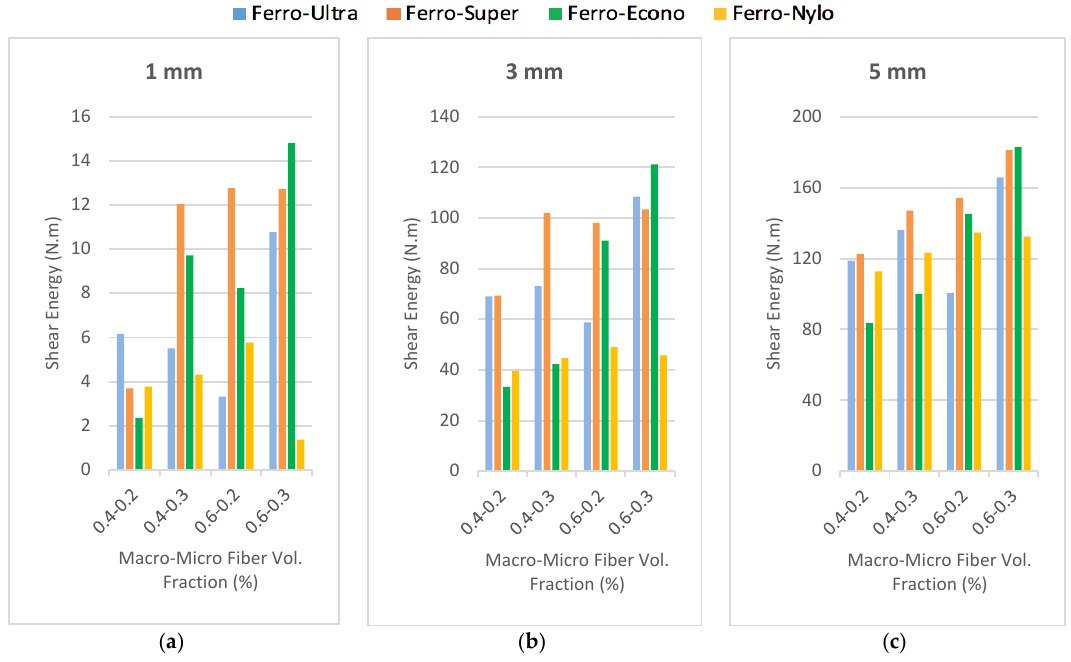
Figure 10. HyFRC comparison by fiber dosage tier at ( a ) 1 mm, ( b ) 3 mm, and ( c ) 5mm deflections.